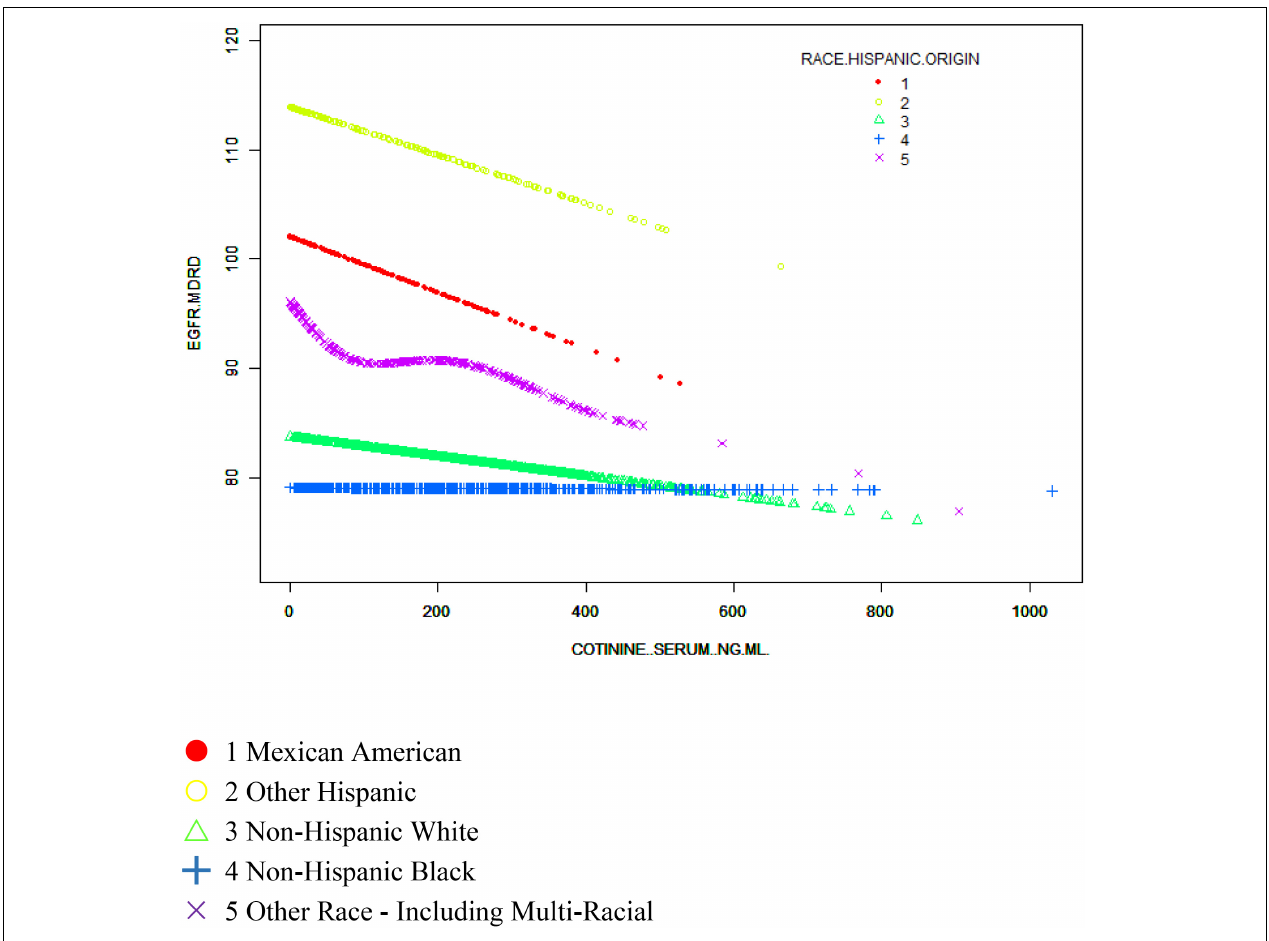
FIGURE 4 | The association between serum cotinine and the eGFR stratified by race/ethnicity. Age, sex, educational background, the ratio of family poverty to income, marital status, BMI, glycosylated hemoglobin, blood glucose, BUN, triglycerides, and uric acid albumin were